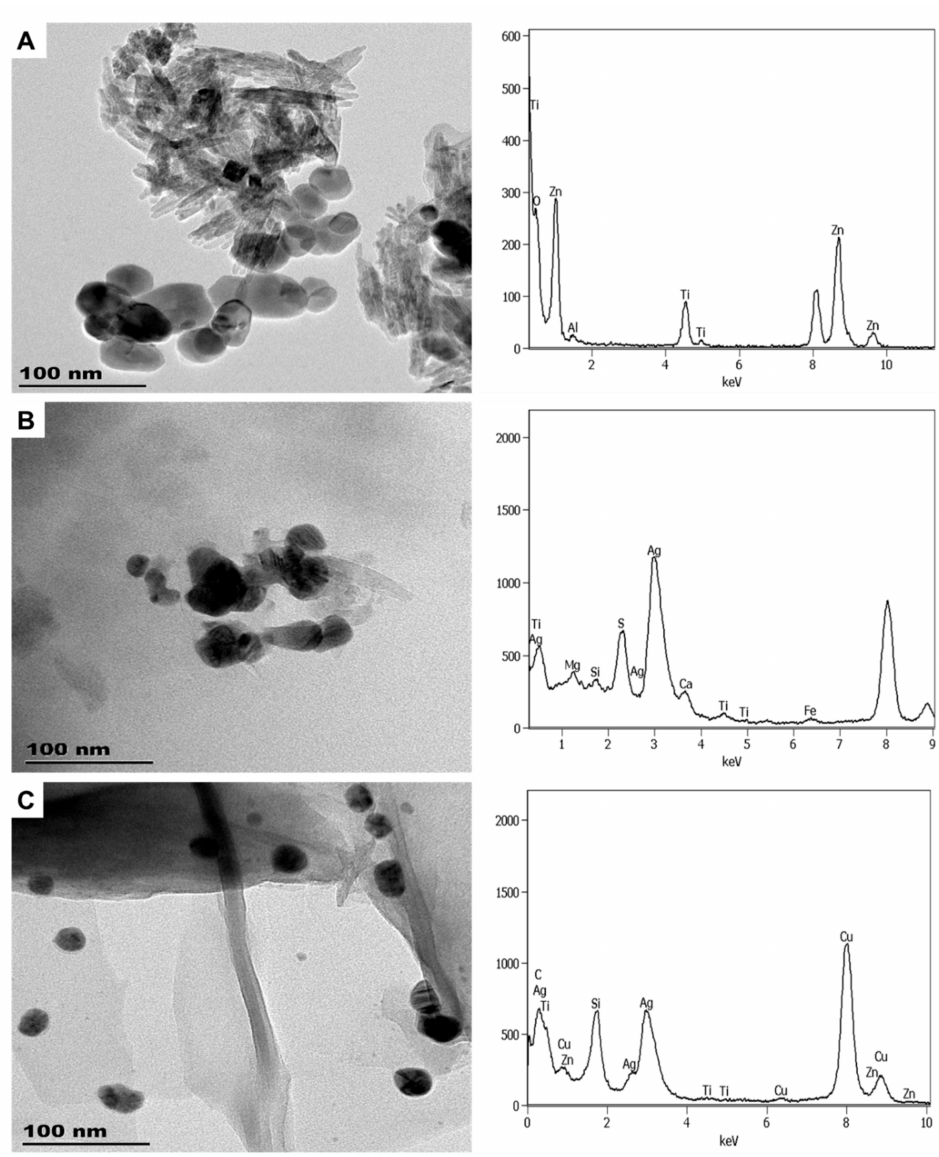
Figure 4. The images and spectra of TEM-EDX analysis of LB1 ( A ), CA1 ( B ), and CA2 ( C